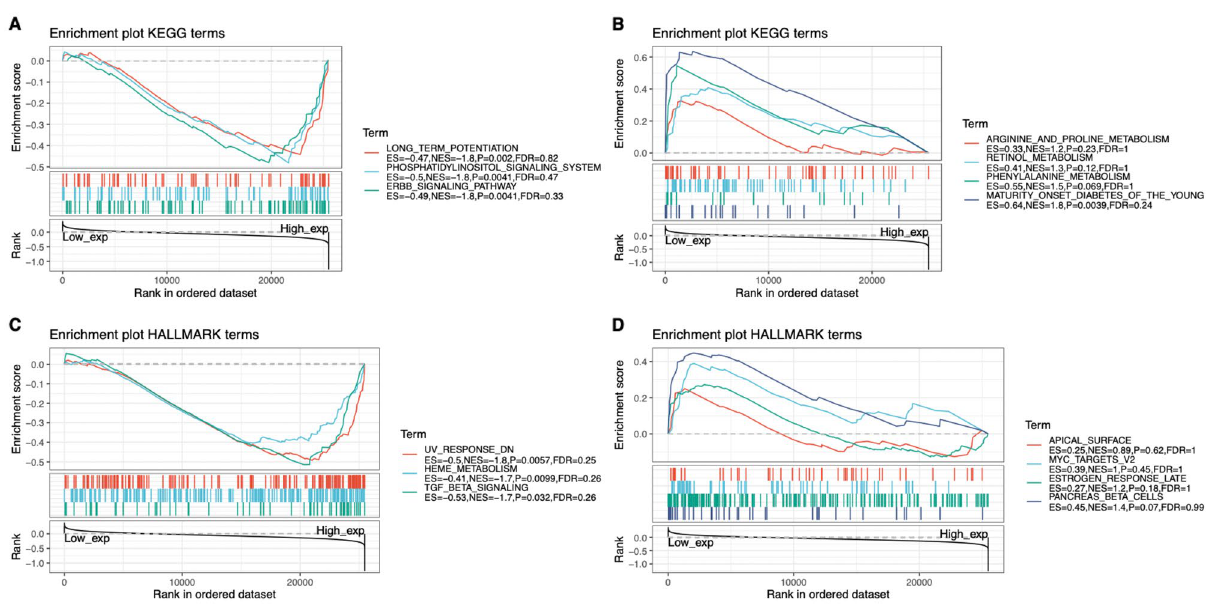
Figure 8. Biofunctional analysis of CD47 across cancers. KEEG terms showed top three negative enrichment gene sets ( A ) and top three positive ones ( B ). HALLMARK terms demonstrated top three negative enrichment gene sets ( C ) and positive ones ( D ) respectively. ( A , B ) High expression of CD47 was negatively associated with long-term potentiation, phosphatidylinositol signaling system and ERBB signaling pathway, and positively associated with arginine/proline/metabolism, retinol/metabolism, phenylalanine/metabolism. ( B , C ) Increased expression of CD47 was negatively linked to UV response, heme metabolism, TGF-beta pathway, and positively associated with the apical surface, MYC and estrogen response